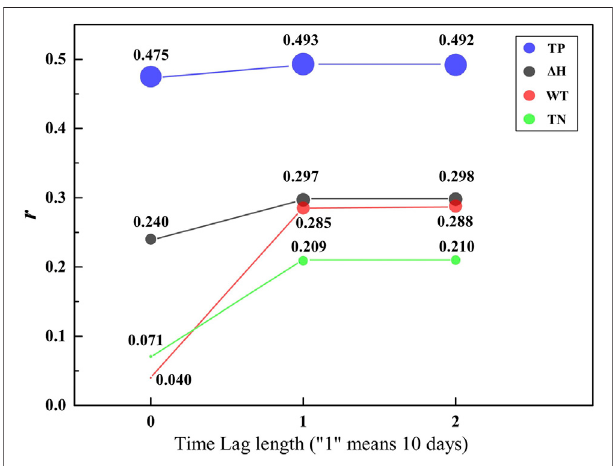
FIGURE6| Thechangeof r underdifferenttime-laglengthsanddifferent driving factors.